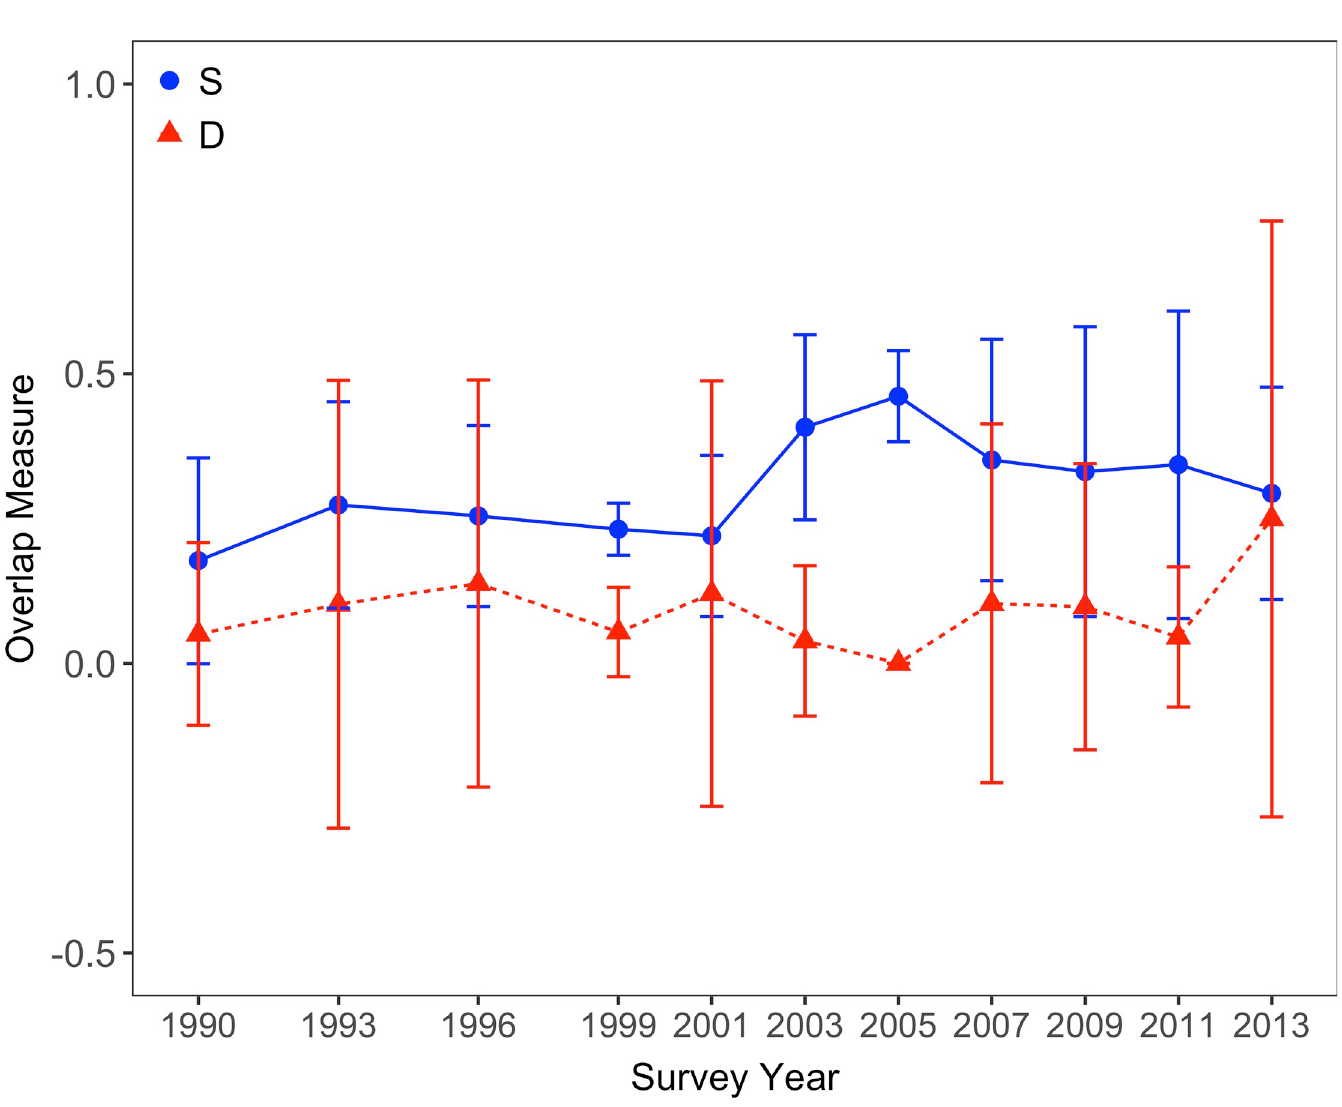
Fig 7. Niche overlap estimates for Pacific Halibut and Arrowtooth Flounder in the Gulf of Alaska (1990 to 2013). Spatial overlap (S) is denoted by blue circles and solid lines. Dietary overlap (D) is denoted by red triangles and dashed